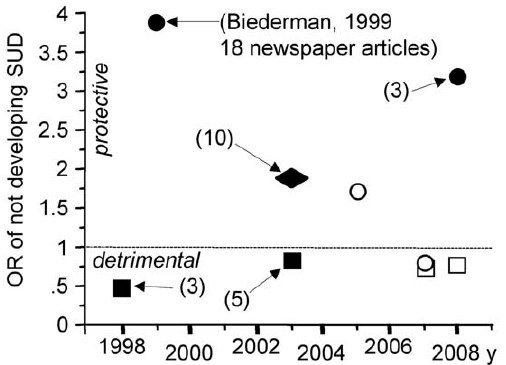
Figure 3. Association between ADHD and the dopamine transporter level in initial and subsequent studies. Dougherty and coworkers (1999) used brain imaging to show that the dopamine transporter was more abundant ( + 70%) in the striatum of ADHD adults than in control subjects. Subsequent studies did not confirm this observation (data from a meta-analysis [59]). The effect calculated by this meta-analysis is indicated by a diamond. Only one subsequent study (filled circle) was echoed in newspapers (number of articles in parentheses). Empty symbols indicated that the corresponding scientific article has not been echoed by newspapers.